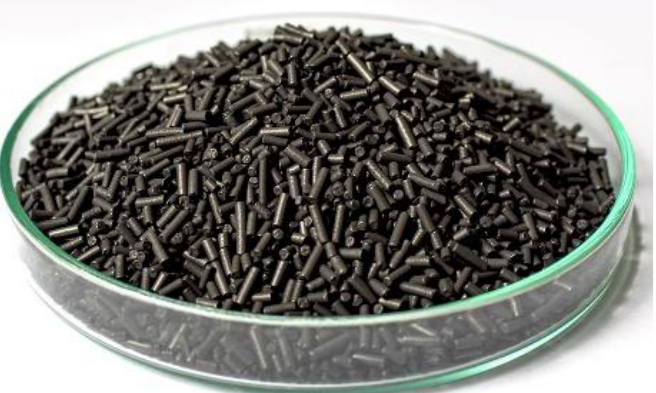
Figure 6. Carbon molecular sieve (reprinted with permission from Ref. [37]).